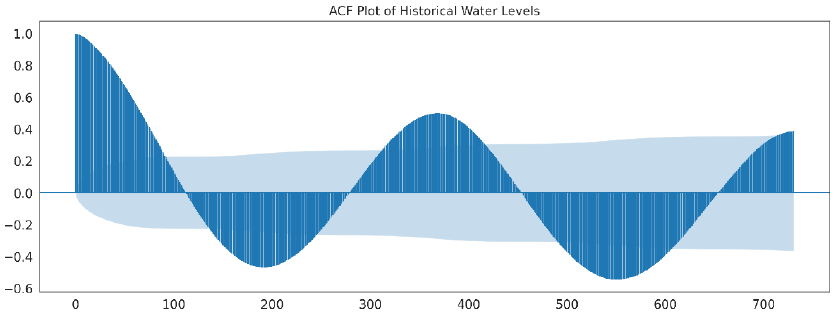
Figure 6. Autocorrelation Plot of Historical Water Levels for lags up to 730. Seasonality is illustrated by the periodic shape, with peaks occurring every 365 days.